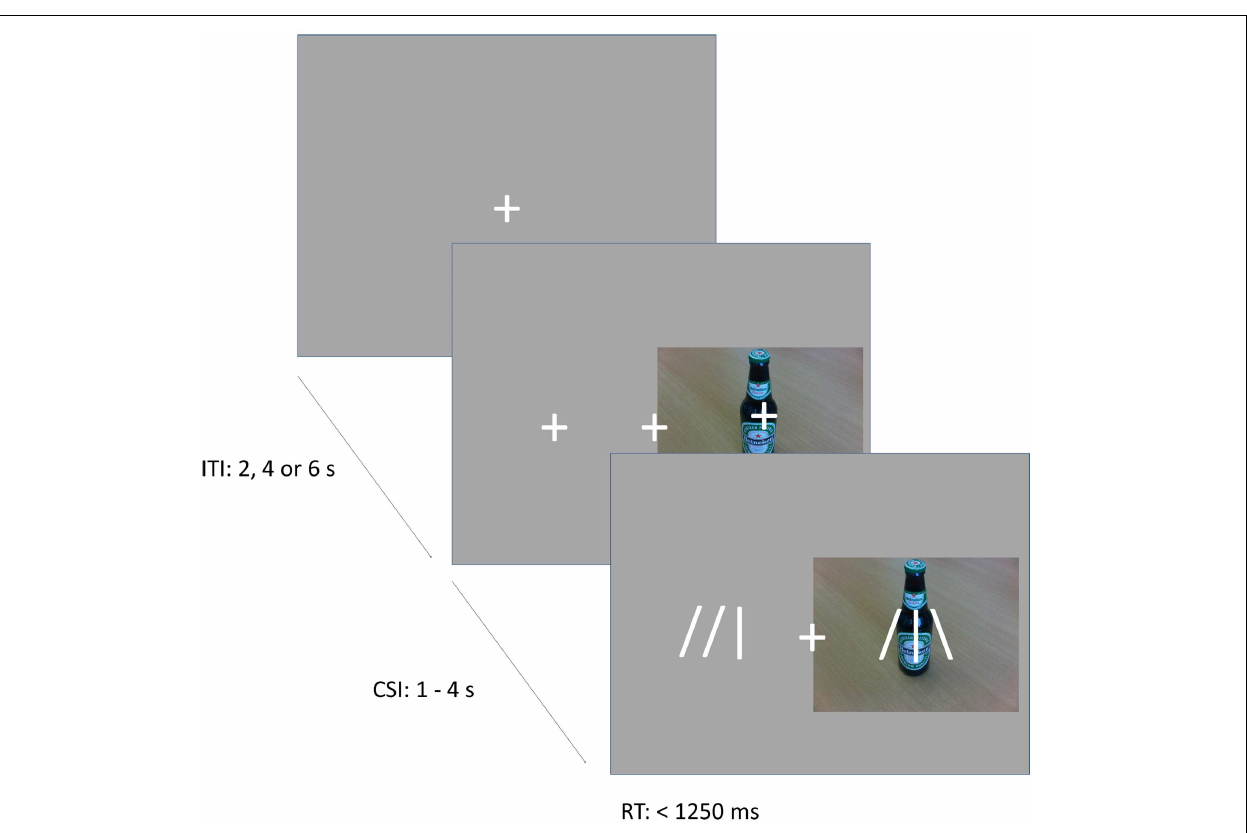
FIGURE 1 | Illustration of the task .The figure shows an example of valid probe trial in an approach alcohol block, or an invalid probe trial in an avoid-alcohol block.The probe appears at the location of the cue, requiring an “up”